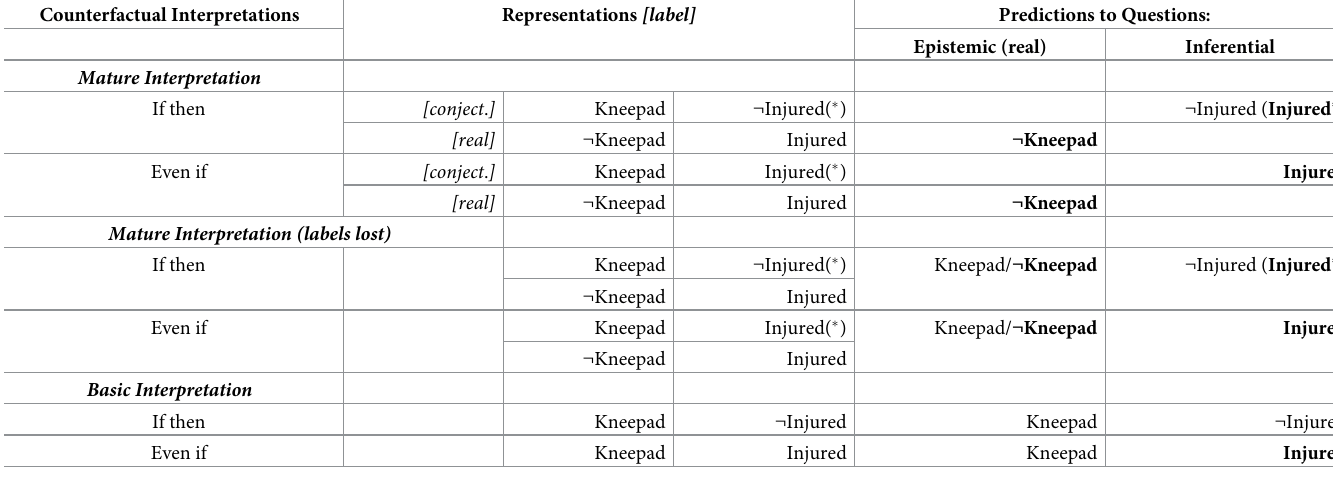
Table 1. Predictions (correct responses in bold) for the inferential and epistemic questions in Experiments 1 and 2, for the mature (with and without labels) and basic interpretations of counterfactuals with “if” and “even if” counterfactuals based on their initial representations. See text for details. Counterfactual